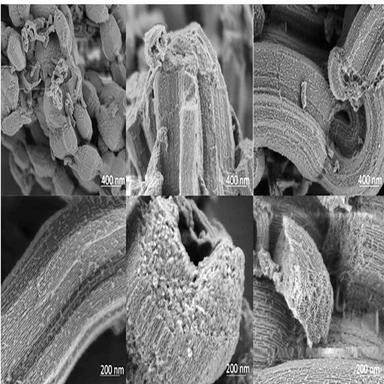
Selected imaged areas of Au-loaded mesoporous silica by SLEEM operating with 0.6 keV energy electron beam.